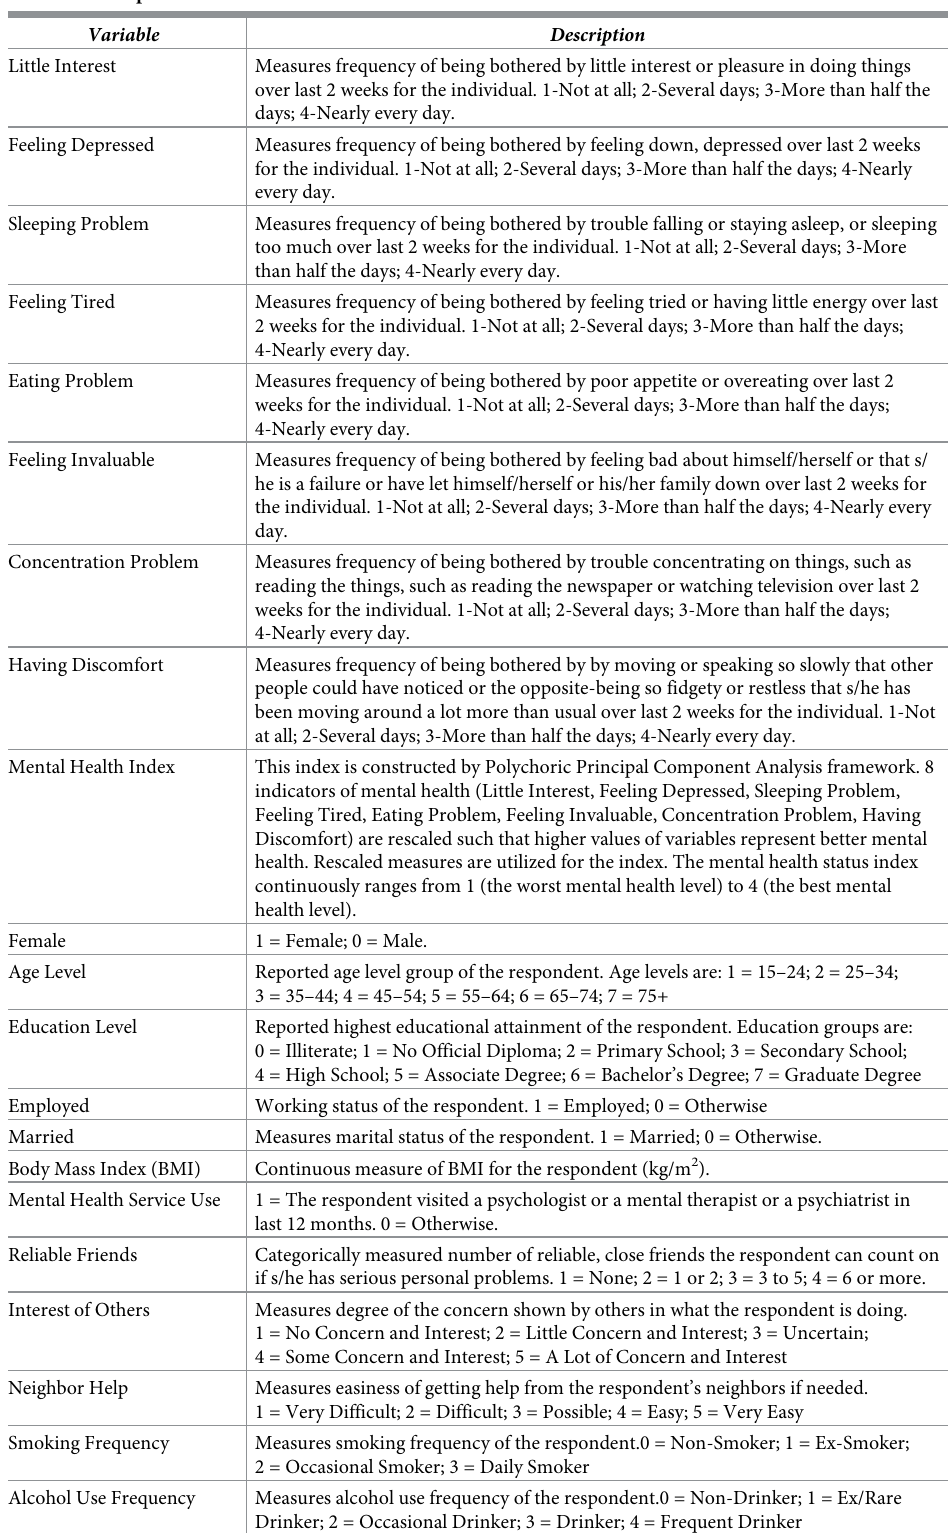
Table 1. Description of